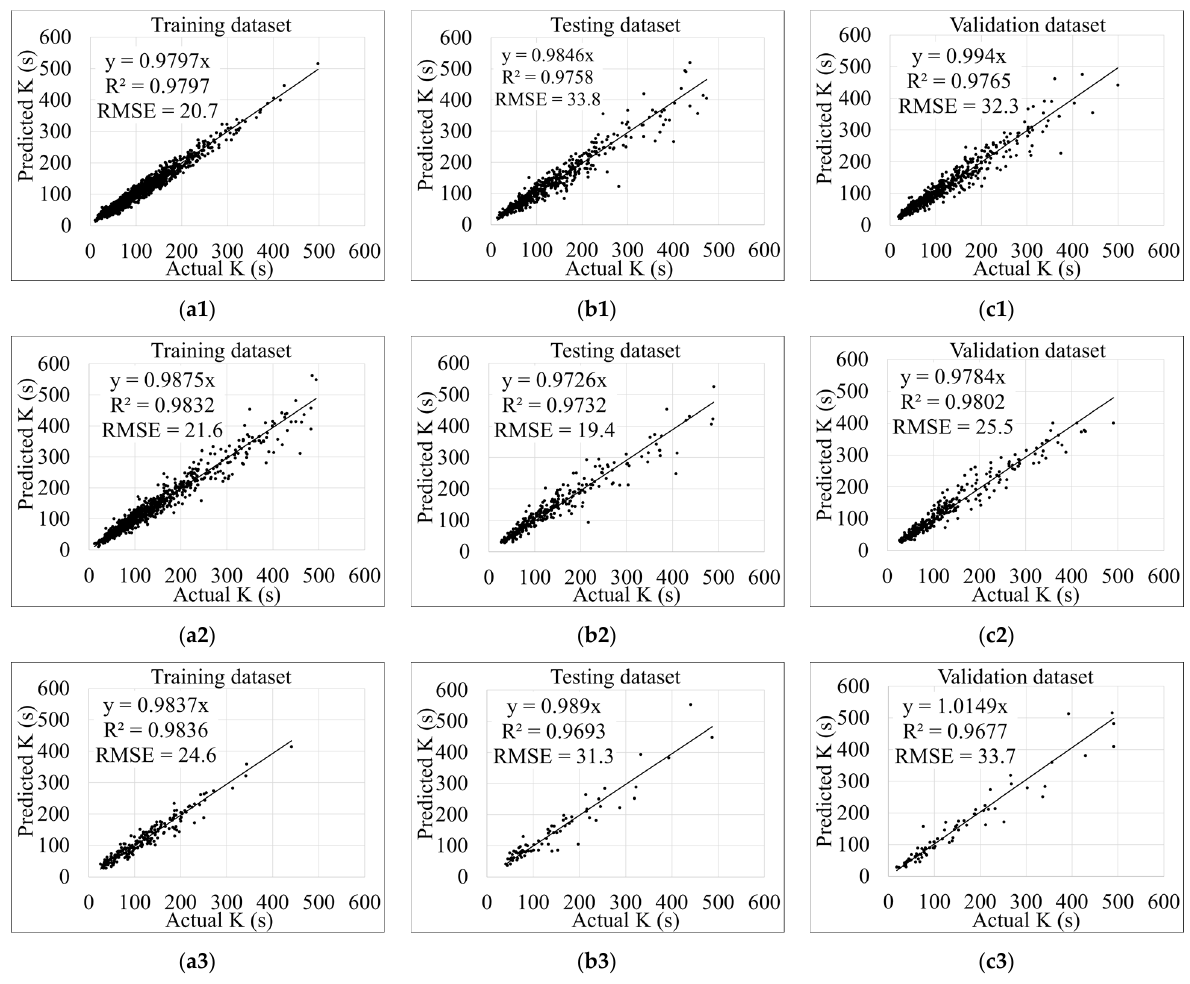
Figure 7. Predicted versus computed stop penalty of light-duty truck (LDT) groups: ( 1 ) LDT1, ( 2 ) LDT2, ( 3 ) LDT3, ( a ) training data, ( b ) testing data, ( c ) validation data.